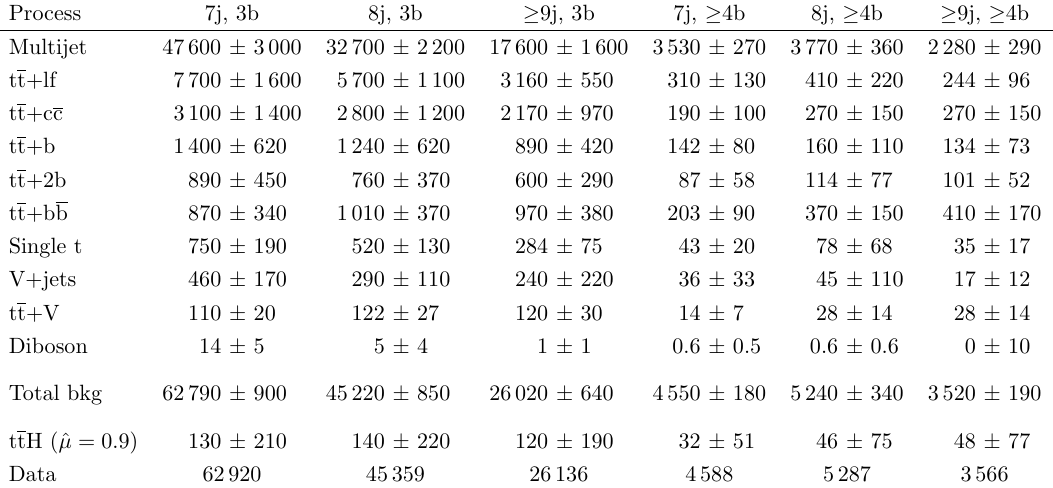
Table 3 . Expected numbers of ttH signal and background events, and the observed event yields for the six analysis categories, following the (cid:12)t to data. The signal contributions are given at the best (cid:12)t value. The quoted uncertainties contain all the contributions described in section 7 added in quadrature, considering all correlations among the processes.